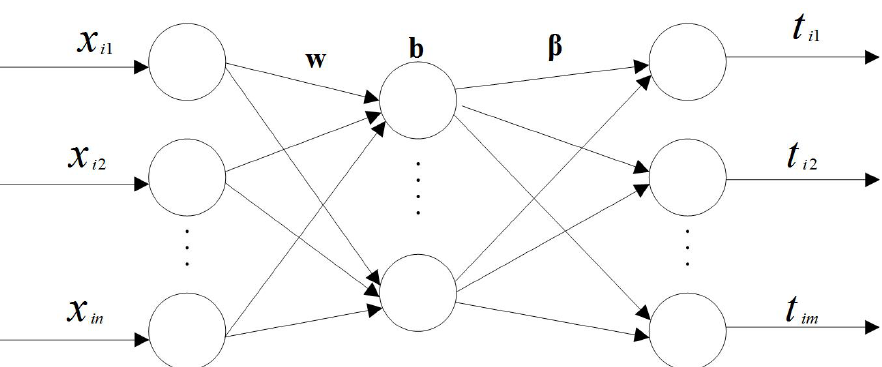
Figure 1. The structure of